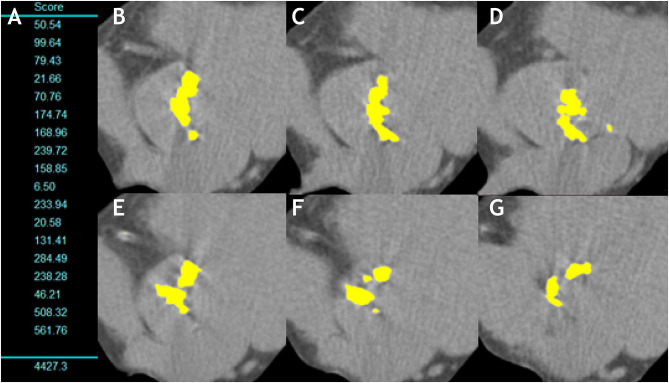
Aortic valve calcification measurement in a man with severe aortic stenosis. (A) Shows the measurement of the aortic valve calcium in each 3-mm slice and total sum (AVC score = 4,427.3AU). (B–G) Show the multiple axial images from aortic annulus to aortic root with any aortic valve calcification highlighted in yellow by the software.